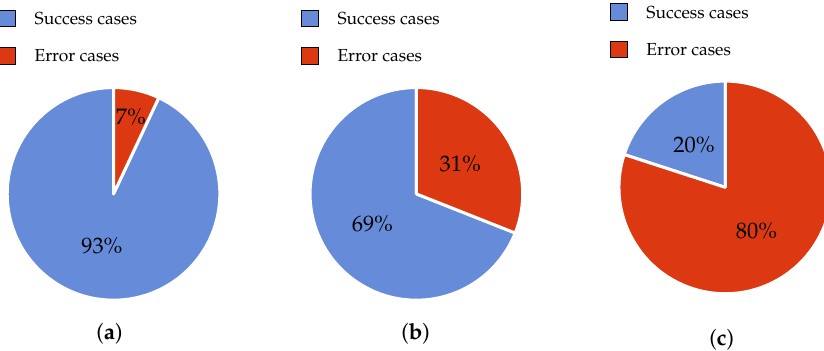
Figure 5. Error rate using a glossy surface paper. ( a ) With the thin wheel model; ( b ) With the thick wheel model; ( c ) Using bible-like paper and the thin wheel